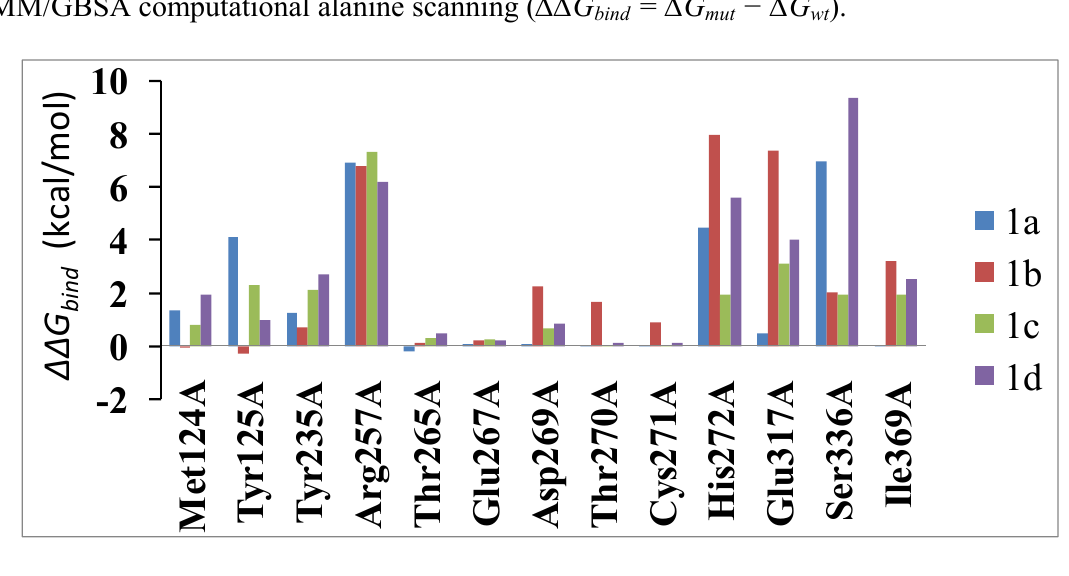
Figure 9. Effects of selected amino acid residues of the TPH1 binding pocket on the calculated free energies (kcal·mol − 1 ) for the binding of four ligands to the TPH1 in